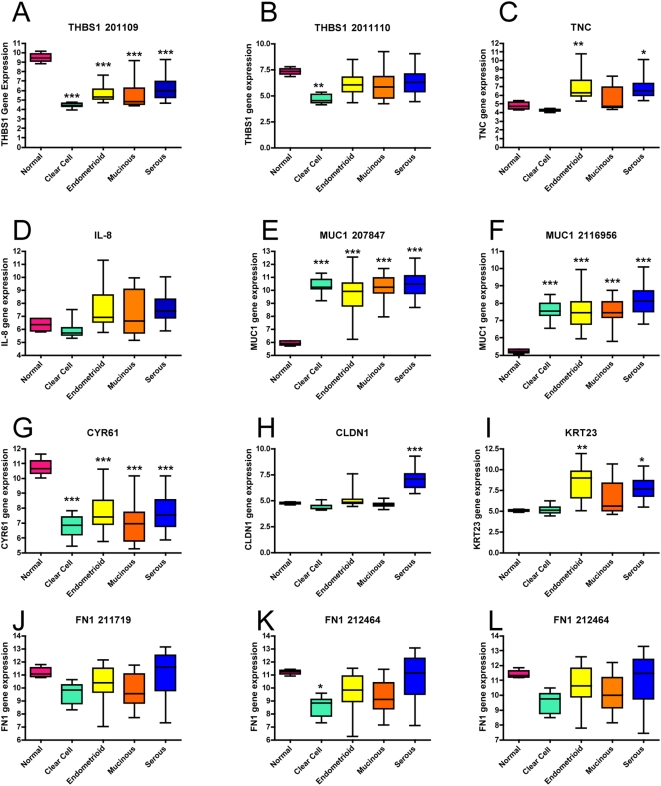

CLDN1 is a biomarker for serous epithelial ovarian carcinoma specimens.Box-plot analyses of data from GSE6008, N = 103 show the drivers THBS1 (A, B), TNC (C), IL-8 (D), MUC1 (E, F), CYR61 (G), CLDN1 (H), KRT23 (I) and FN1 (J, K, L) normalized comparison of gene expression levels. Among all previously-identified drivers in hierarchical clustering, the data demonstrates that CLDN1 is the only one which distinguishes serous when compared with normal, clear cell, endometrioid and mucinous (***P<0.001). The box represents the range of values and the center vertical line inside the box represent the median with whiskers representing the extended range. Results were analyzed by ANOVA and Tukey's Multiple comparison post test; **P<0.05, **P<0.01 and ***P<0.001 of ovarian tumor type vs. normal samples.